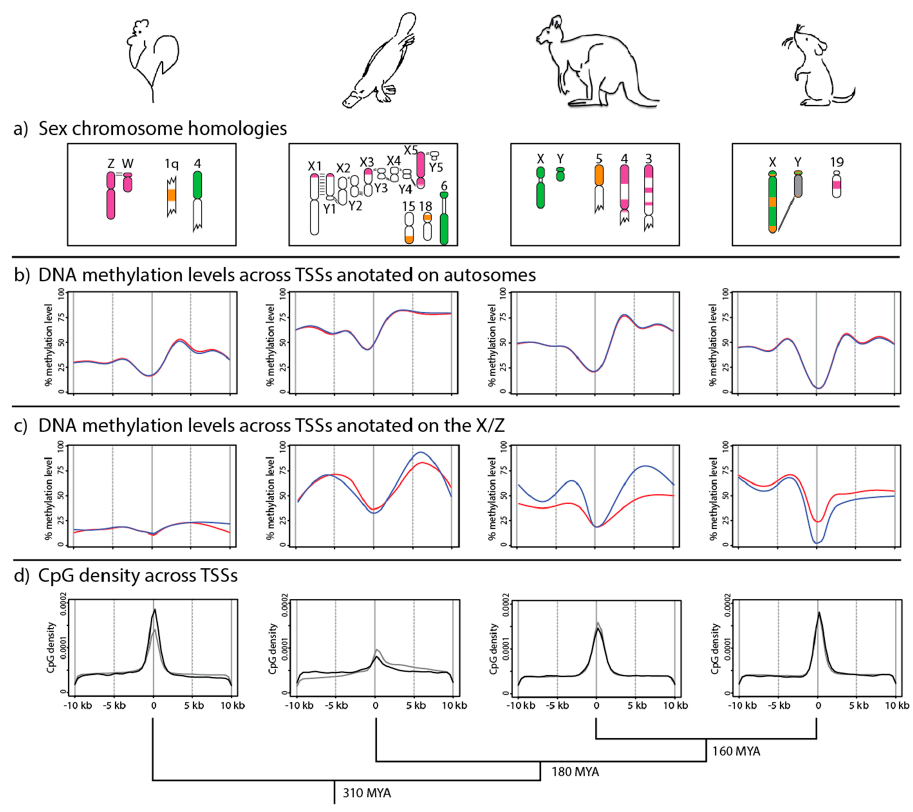
Figure 1. Phylogenetic relationships and DNA methylation profiles of amniote vertebrates. ( a ) Sex chromosome homologies with the therian mammal X conserved region (green) and the eutherian X added region (orange), which is autosomal in marsupials. The platypus X chromosomes and the chicken Z chromosome (purple) share extensive homology, especially X5 which is almost entirely homologous to the chicken Z. However, despite this homology, these sex chromosome systems have independently evolved. ( b ) Metagene analysis (adapted from [9]) of DNA methylation levels across transcription start sites (TSSs) of expressed autosomal genes in males (blue) and females (red). The absolute level of DNA methylation varies between species, but there is a conserved pattern of low DNA methylation flanked by high methylation (especially downstream of TSSs in marsupials, monotremes, and birds). ( c ) Metagene analysis (adapted from [9]) of DNA methylation levels across TSSs of all genes annotated on the chicken Z and platypus Xs, and genes subject to X chromosome inactivation (XCI) in marsupials and eutherians, in males (blue) and females (red). In chicken and platypus, the methylation patterns do not vary between sexes. However, in female marsupials, DNA methylation flanking TSSs is reduced relative to males, whereas, in female eutherians, DNA methylation at TSSs is increased relative to males. ( d ) Density of CpG dinucleotides relative to annotated TSSs on autosomes (black) and the X/Z chromosome (grey). In all species, CpG densities peak at TSSs, with X chromosomes mirroring the autosomes in therian mammals. The change in X chromosome versus autosome density in platypus likely results from the relatively few genes anchored to the Xs. The chicken Z chromosome has a reduced density of CpGs at TSSs compared to the autosomes, which could result from a diminished function for DNA methylation in Z chromosome gene regulation (see text).